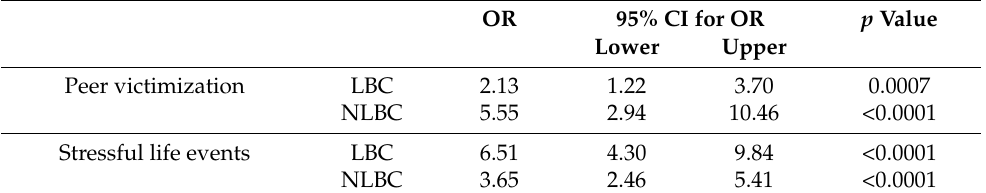
Table 5. Odds ratios of risk factors on depressive symptoms for LBC and NLBC. OR 95% CI for OR p